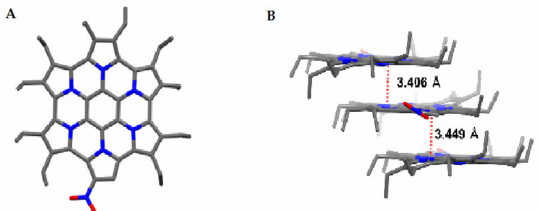
Figure 1. Crystal structures of 2a . ( A ) Top view and ( B ) packing structures with the selected atomic